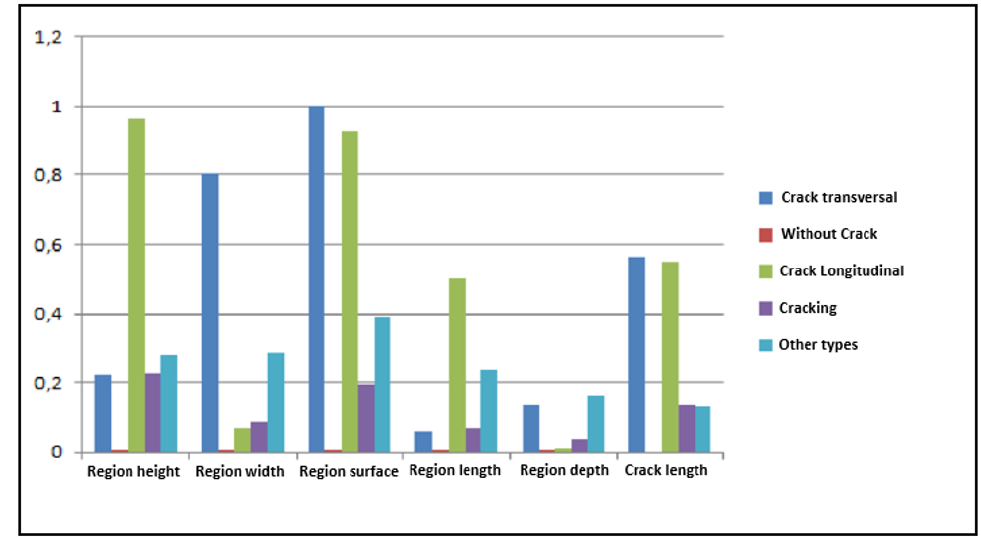
Figure 13. Variation of interclass primitives (X-axis: Primitives associated with each class of crack; Y-axis: Percentage).